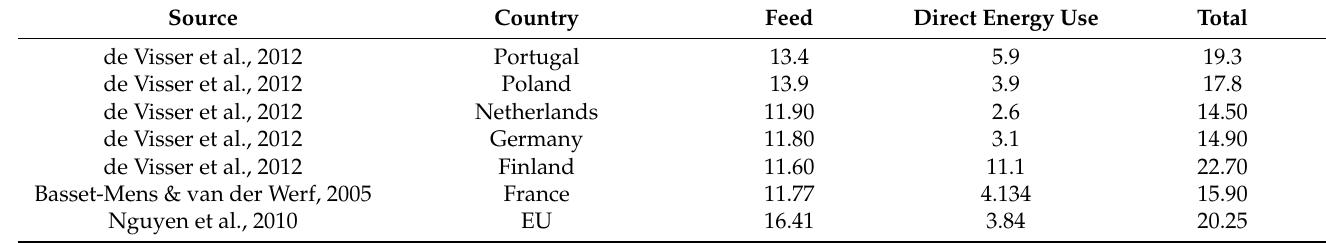
Table A3. Energy inputs for pig production slaughter weight MJ/kg (based on [13,14,21]).